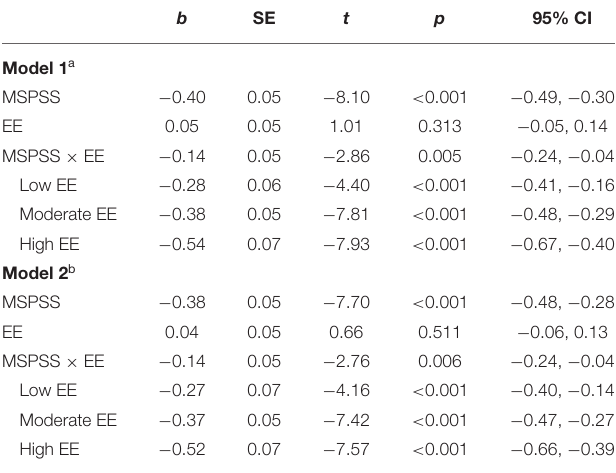
TABLE 3 | Regression coefficients from analyses of moderating effect of earthquake exposure on the relationship between perceived social support and mental health